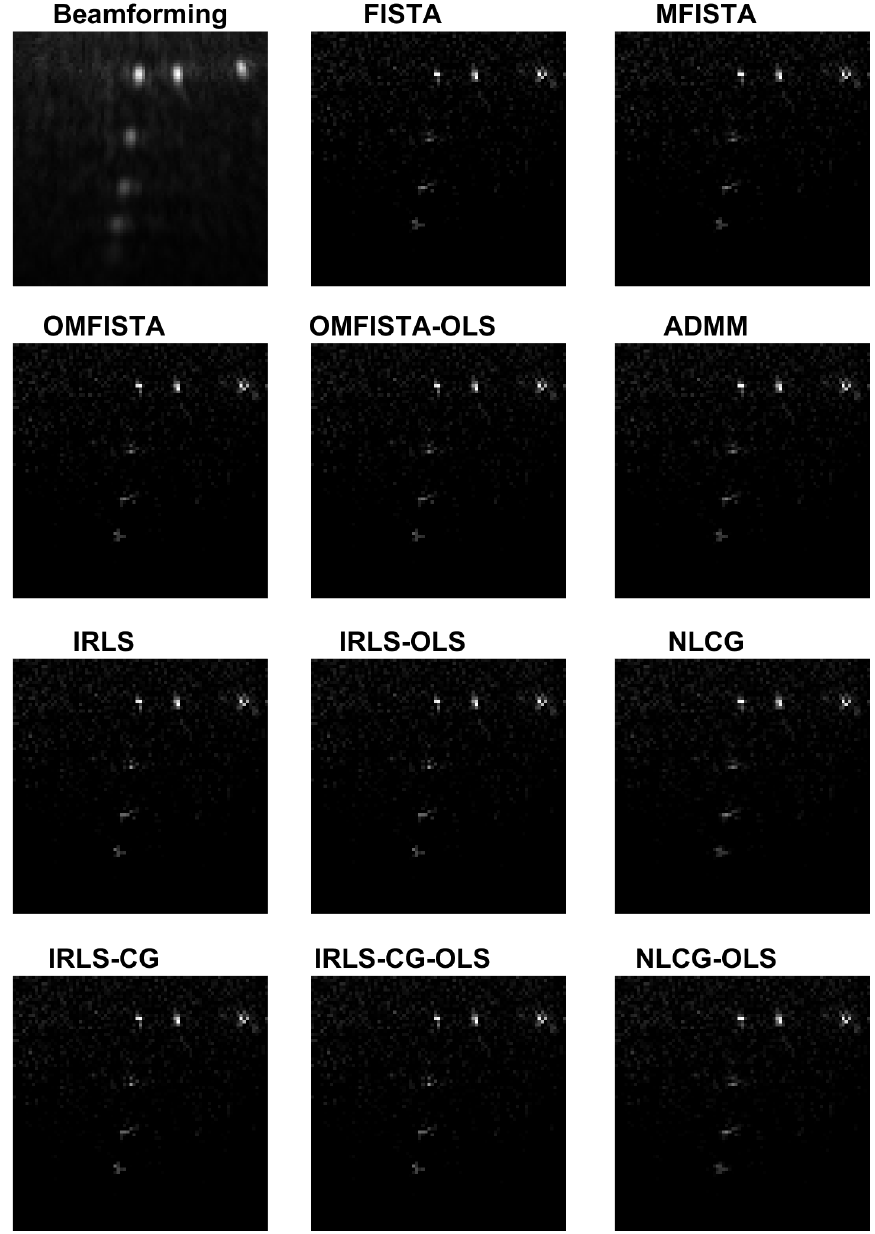
Figure 16. Reconstructed images from the real